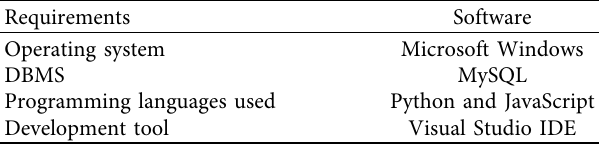
Table 1: Software Requirements